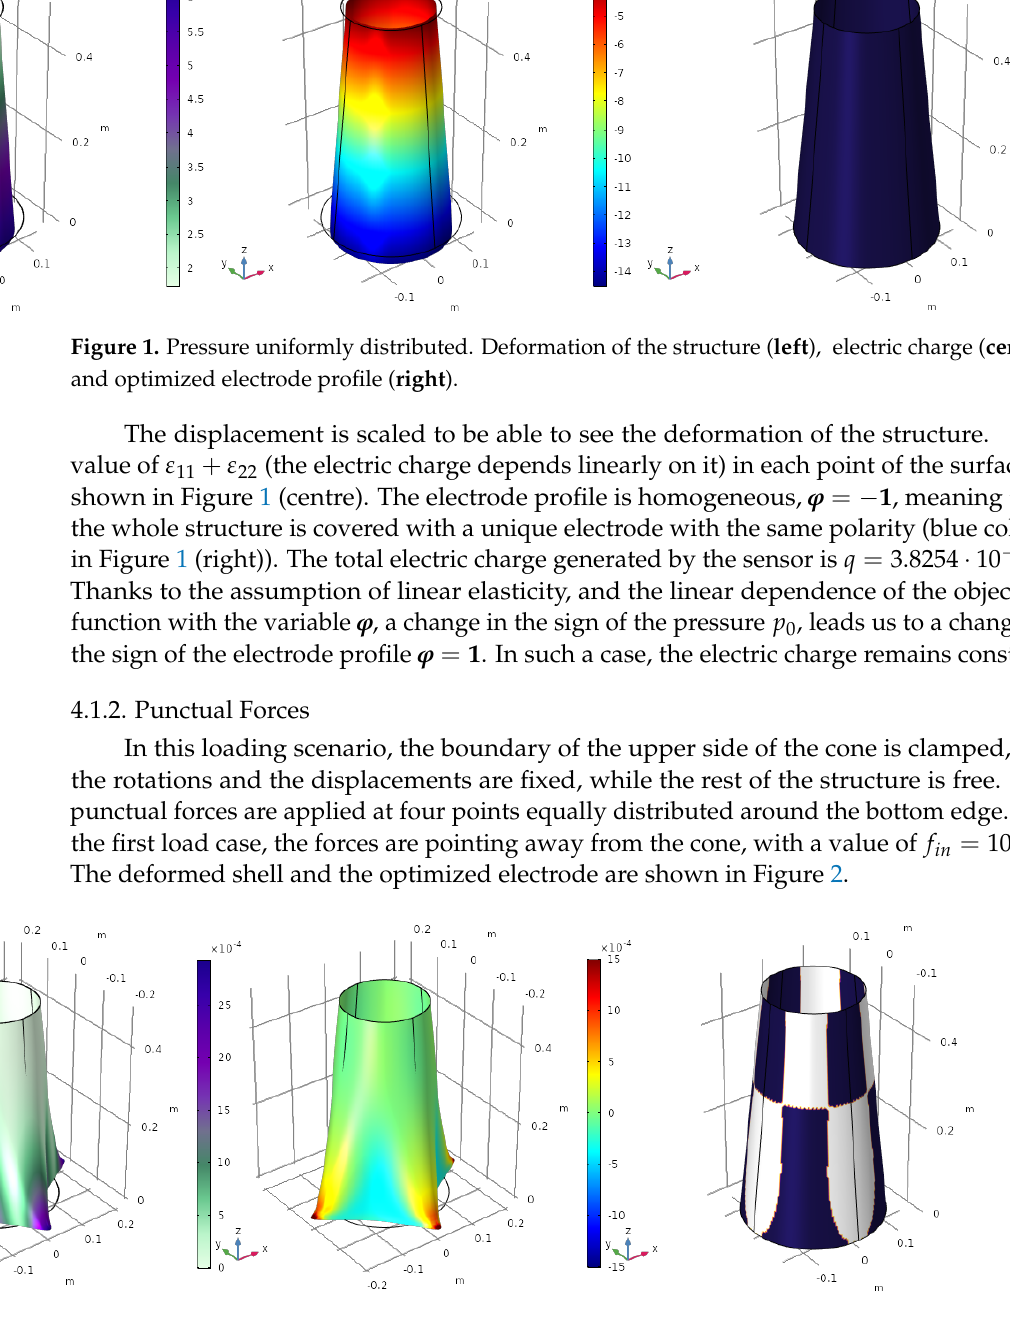
Figure 2. First load case. Deformation of the structure ( left ), electric charge ( centre ) and optimized electrode profile ( right